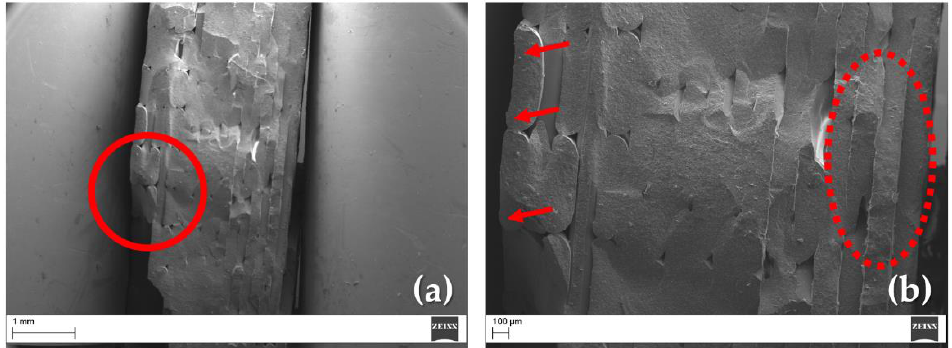
Figure 7. SEM analysis of the sintered sample’s fracture surface: ( a ) initial crack point (red circle); ( b ) FFF-induced defects (red arrows) and bottom layers (red dashed